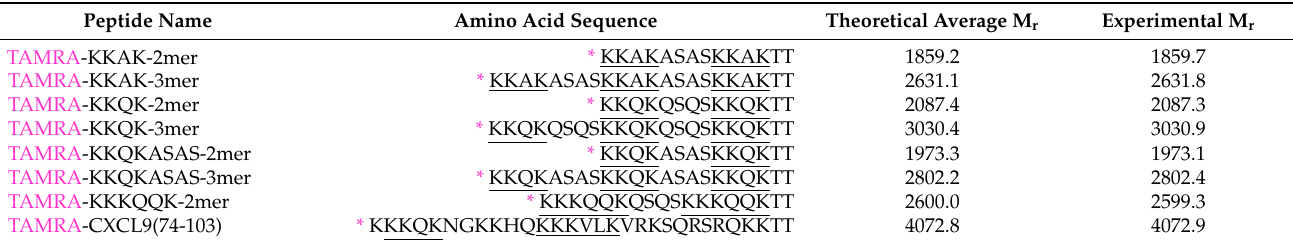
Table 1. Overview of the chemically synthesized